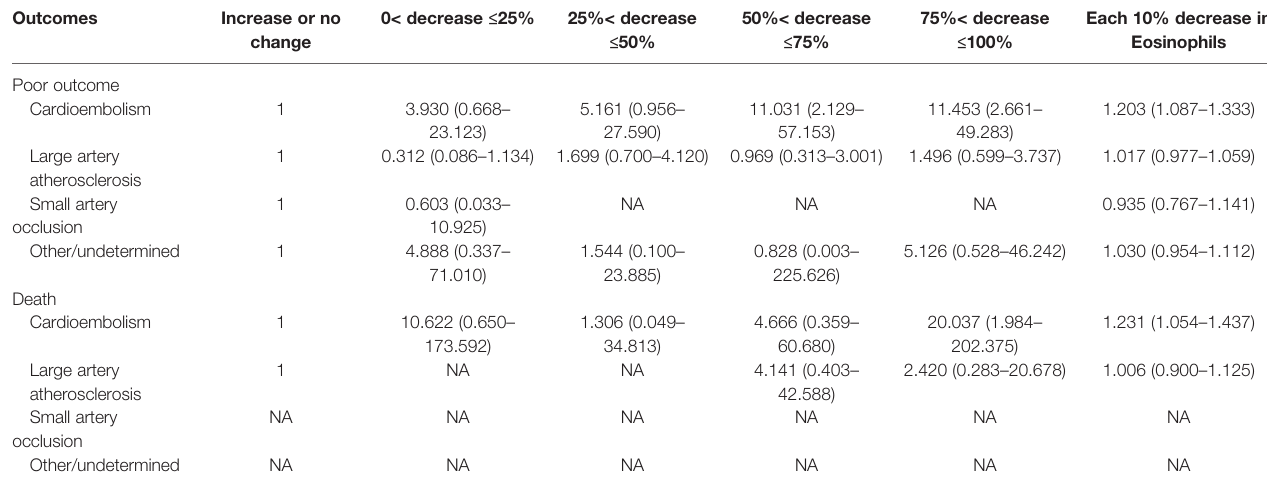
TABLE 3 | Adjusted odds ratios of adverse outcomes at 3-month according to eosinophil changes after Intravenous thrombolysis in different TOAST subtypes. Outcomes